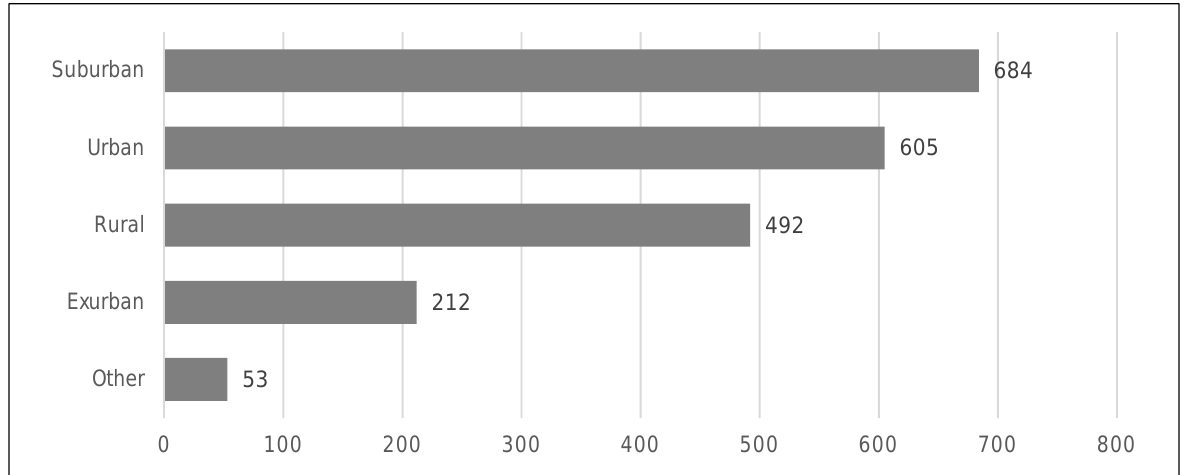
Figure 1. Number of Respondents Working for or on Behalf of Local, Regional, and Metropolitan (LRM) Governments Serving Urban, Suburban, Exurban, Rural, and Other